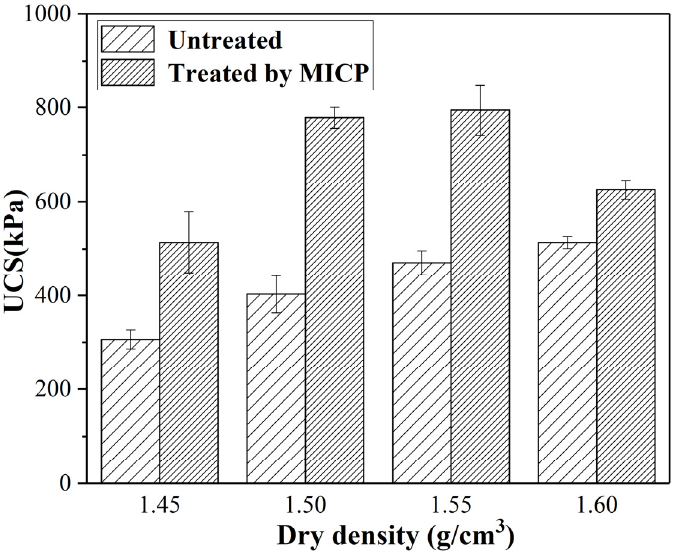
Figure 1. Unconfined compression strengths of silt samples with different dry densities.